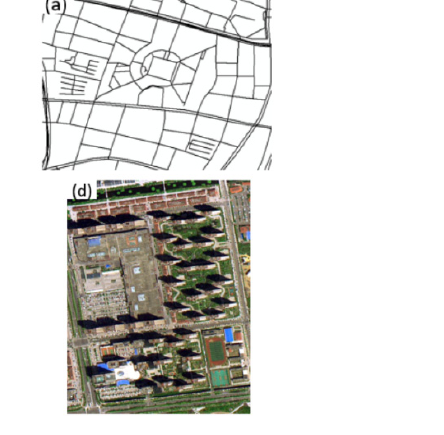
Figure 5. Road network processing and block generation: ( a ) original OSM road network; ( b ) road buffers from OSM; ( c ) segmentation results based on OSM road buffers; ( d ) raw image; ( e ) the OSM before editing; and ( f ) the OSM after editing.